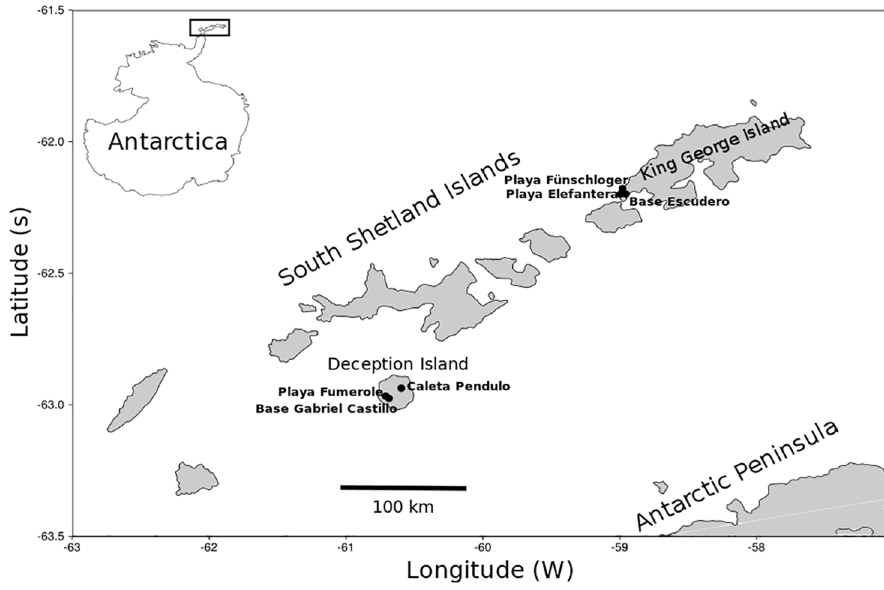
Fig 1. Map of the study sites on King George and Deception Islands, both located in the South Shetland Islands group off the Antarctic Peninsula.